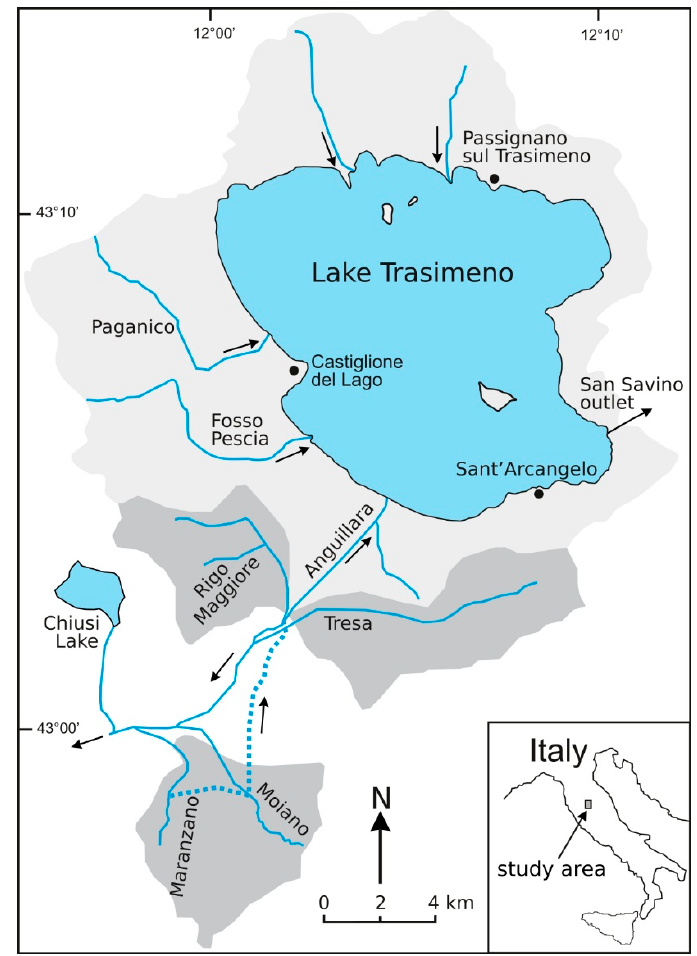
Figure 1. Location of the study area and main features of the Lake Trasimeno basin. The light grey area indicates the natural catchment of lake Trasimeno and the dark grey areas indicate the river basins artificially connected to the lake after 1957. The blue dotted line represents the artificial waterway connecting the Moiano and Maranzano river basins to the Anguillara channel.